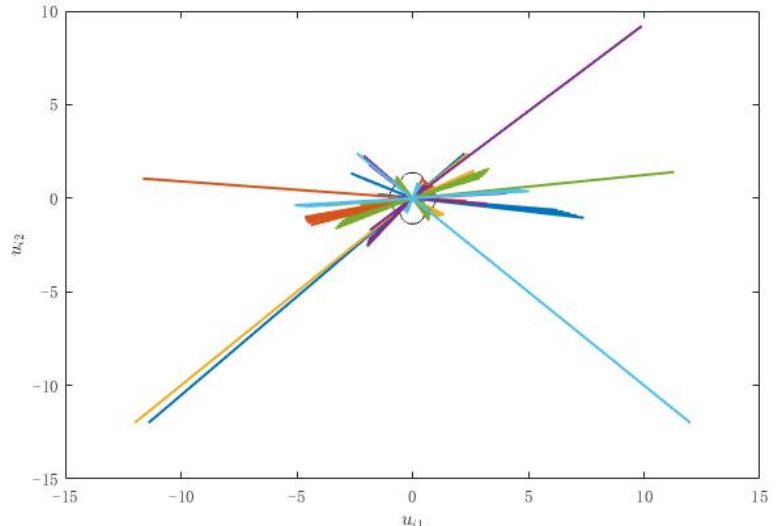
Figure 7. Control input without constraints.